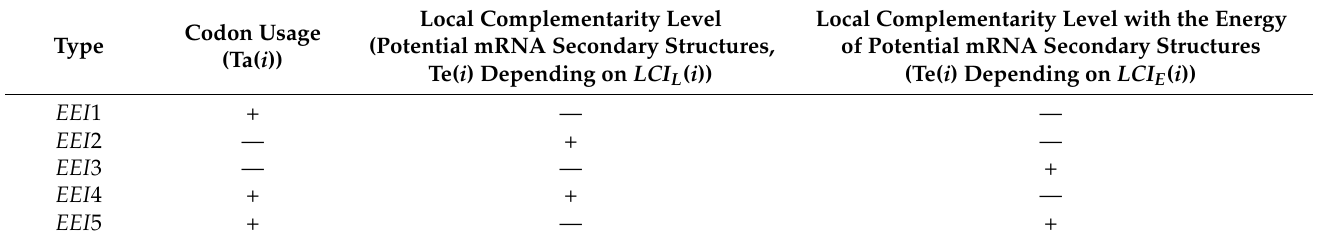
Table 3. The description of elongation efficiency types ( EEI types)